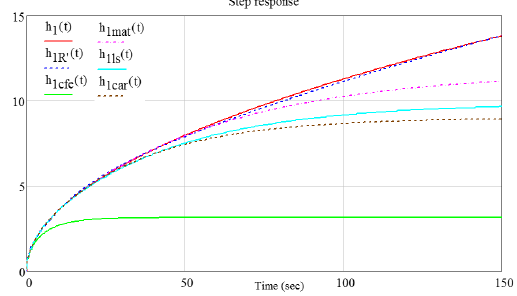
Fig. 1: Time responses